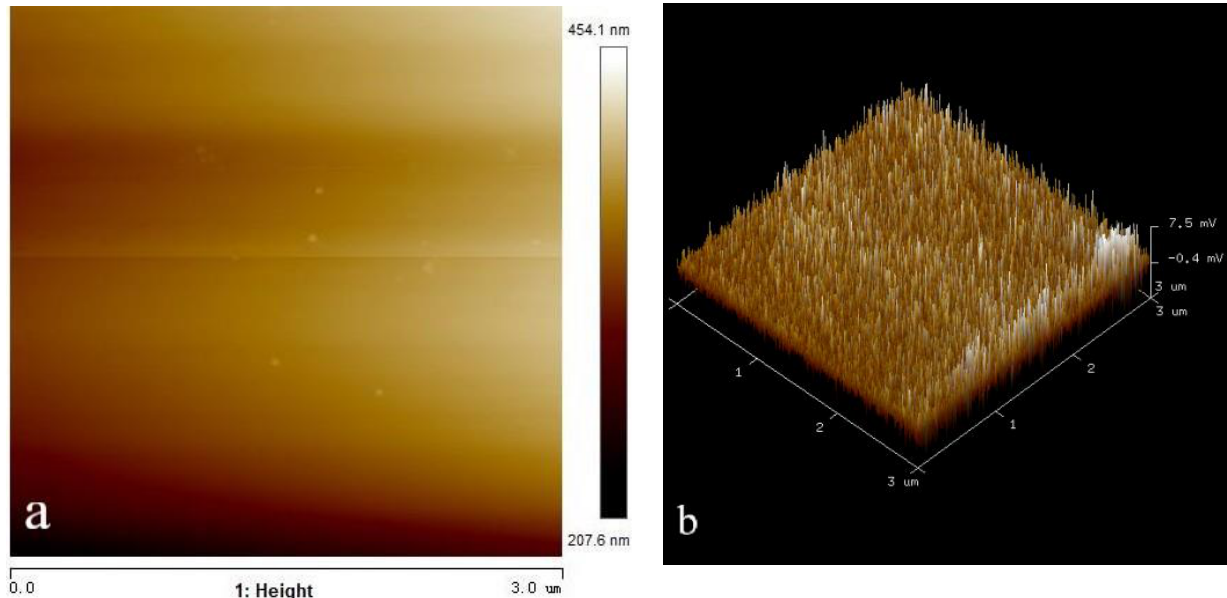
Figure 12. AFM morphology of wolframite grinding tablets after adding octyl hydroxamic acid (50 mg/L). ( a ) height ( b ) 3D.